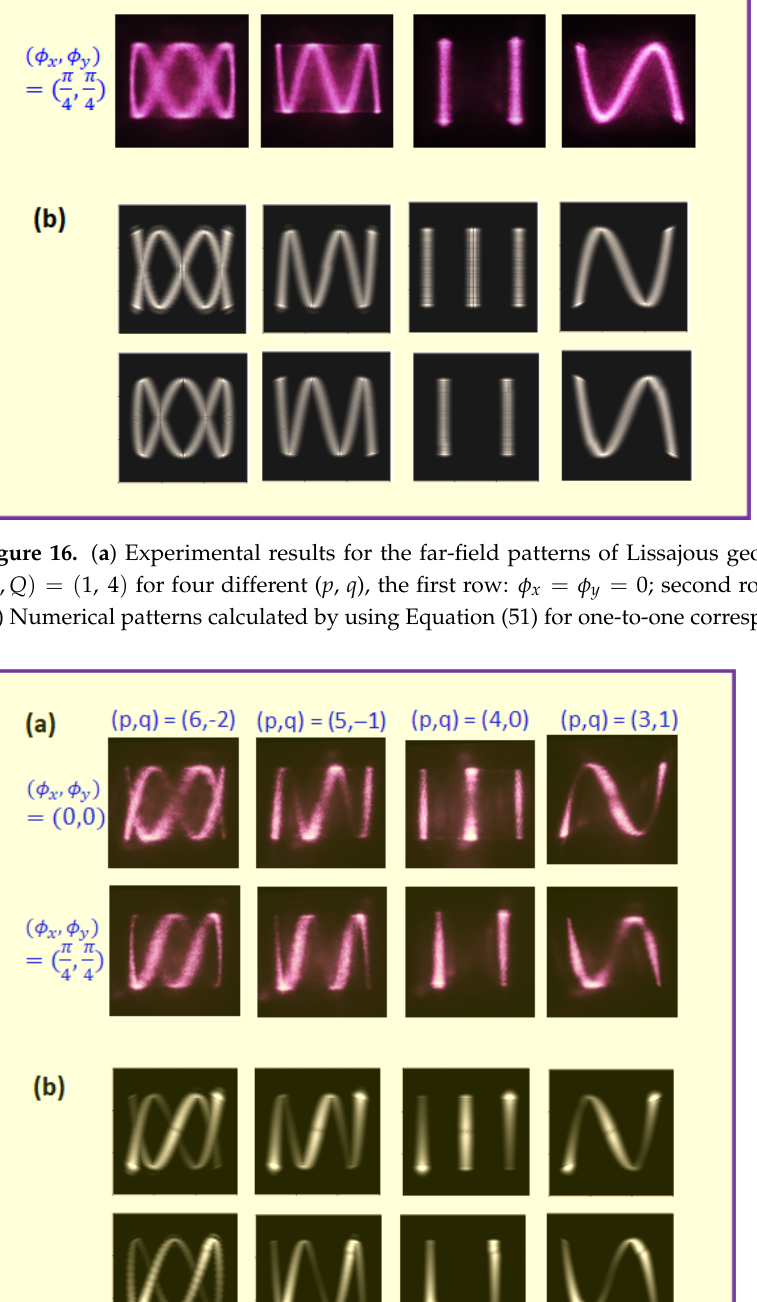
Figure 18. ( a ) Experimental results for the far-field patterns of Lissajous geometric modes generated by using an output coupler with 𝑇 (cid:3042)(cid:3030) = 25% . ( b ) Numerical patterns obtained from Equation (57).